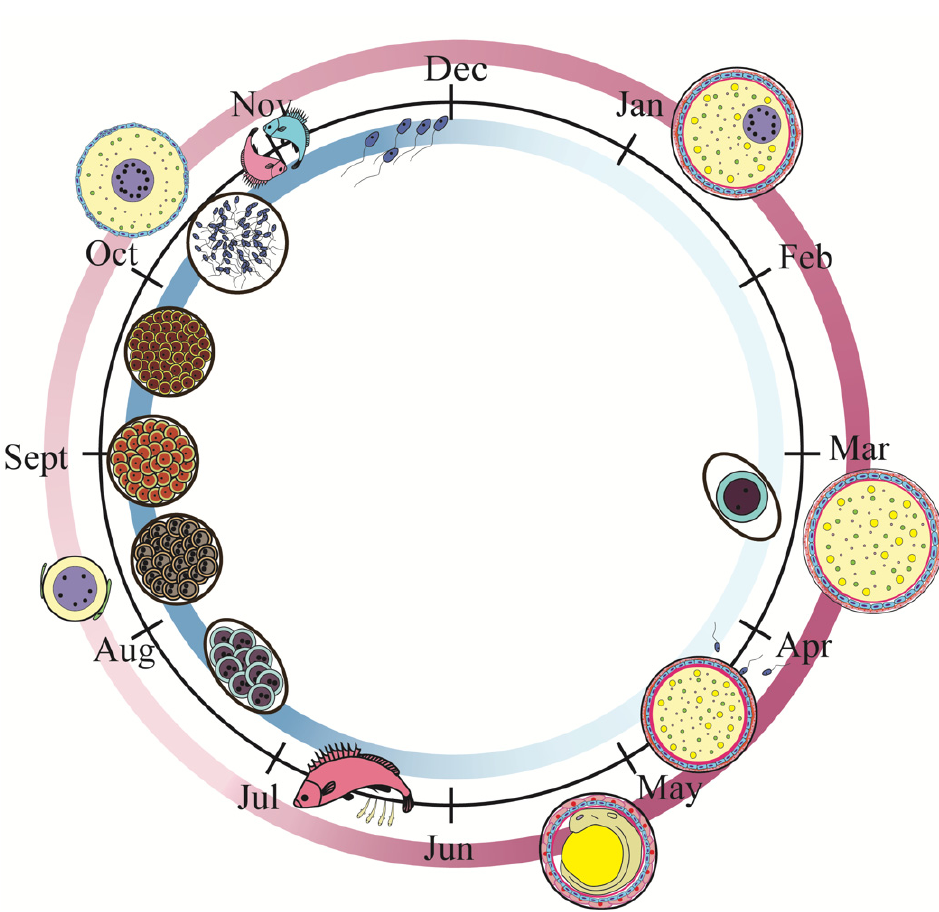
Figure 1. The pattern of the adult S. schlegelii Reproductive cycle. The male of S. schlegelii was mature and copulated from the middle of October to December. The female of S. schlegelii was maturation at about April. The fertilization in vivo occurred between April and May. The time was closely related to the water temperature. Aug–Oct: spermatogenesis; Oct–Dec: sperm maturation; Nov: copulation; Oct–Mar: vitellogenesis; Apr: fertilization; May–Jun: gestation. Mar: March; Apr: April; May: May; Jun: June; Aug: August; Oct: October; Nov: November; Dec: December.